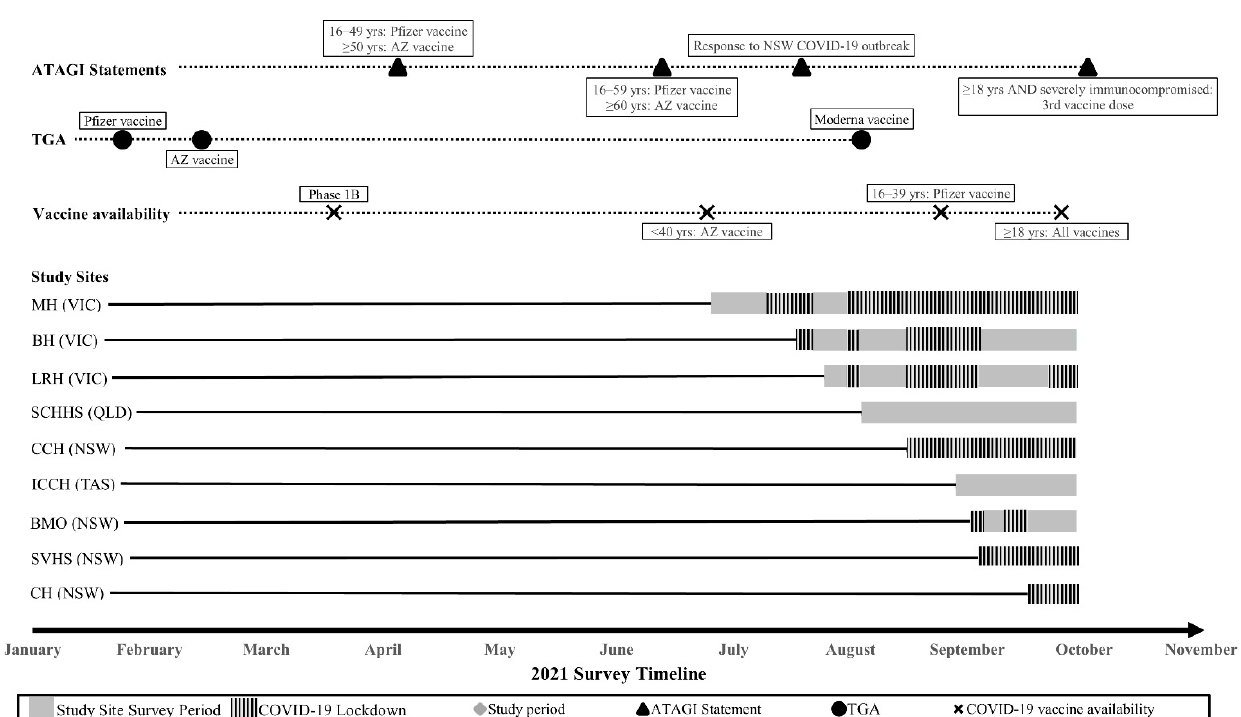
Figure 1. Timeline of study including survey period relative to state-wide strict lockdowns for COVID-19. Abbreviations: ATAGI, Australian Technical Advisory Group on Immunization; years, yrs; AZ, Astra-Zeneca; NSW, New South Wales; TGA, Therapeutic Goods Administration–COVID-19 Vaccine Provisional Registration; MH, Monash Health; VIC, Victoria; BH, Bendigo Health; LRH, Latrobe Regional Hospital; SCHHS; Sunshine Coast Hospital and Health Service; QLD; Queensland; CCH, Central Coast Hematology; ICCH, Icon Cancer Center Hobart; TAS, Tasmania; BMO, Border Medical Oncology; SVHS, St Vincent’s Hospital Sydney; CH, Campbelltown Hospital. People with solid organ tumors were eligible for COVID-19 vaccination from the commencement of the Austral-